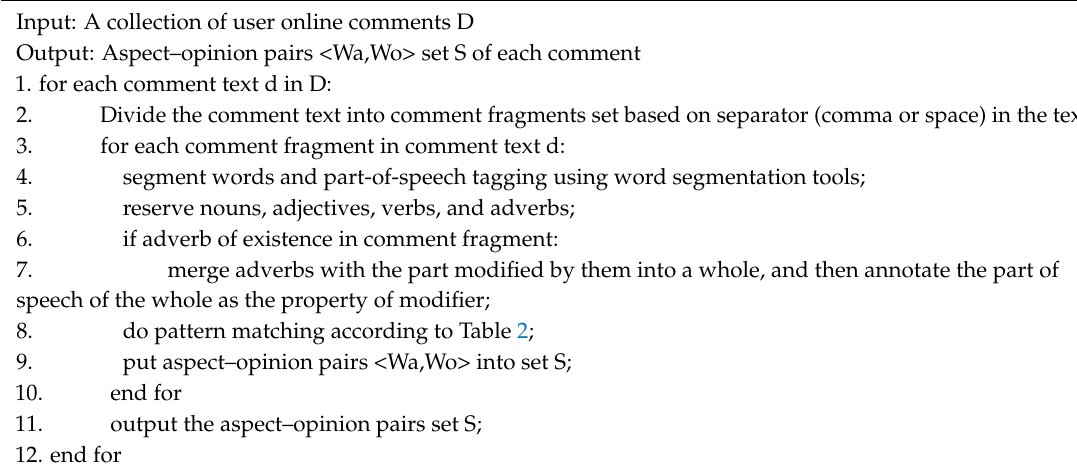
Algorithm 1 : Aspect–opinion pair extraction based on pattern